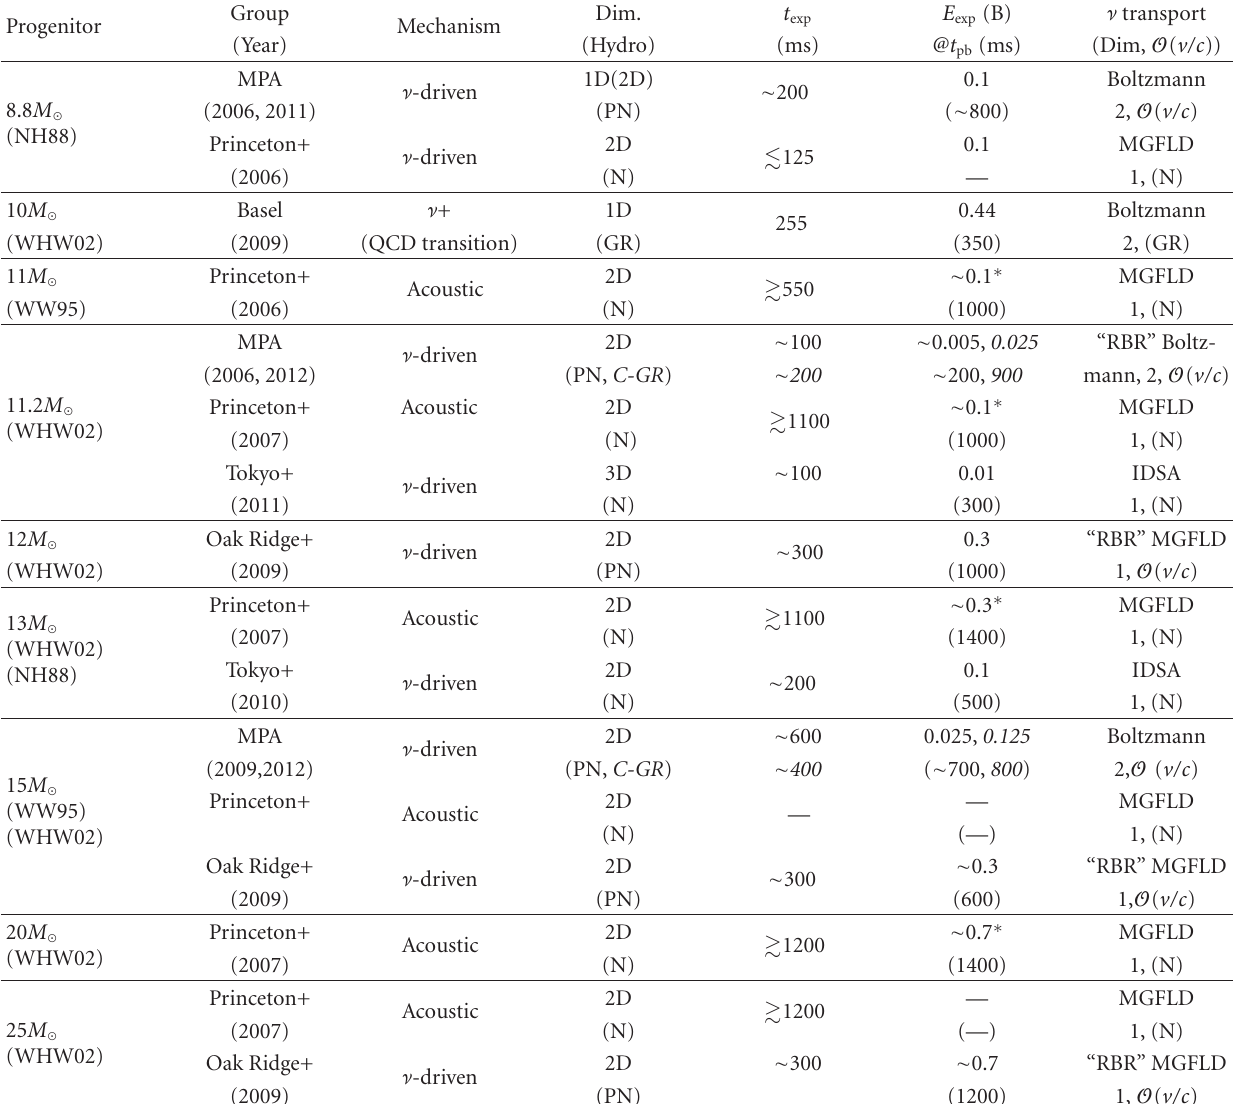
Table 1: Selected lists of recent neutrino-radiation hydrodynamic milestones reported by many SN groups around the world (“Group”), which obtained explosions by the neutrino-heating mechanism (indicated by “ ν -driven”) or the acoustic mechanism (“Acoustic”) (See text for more